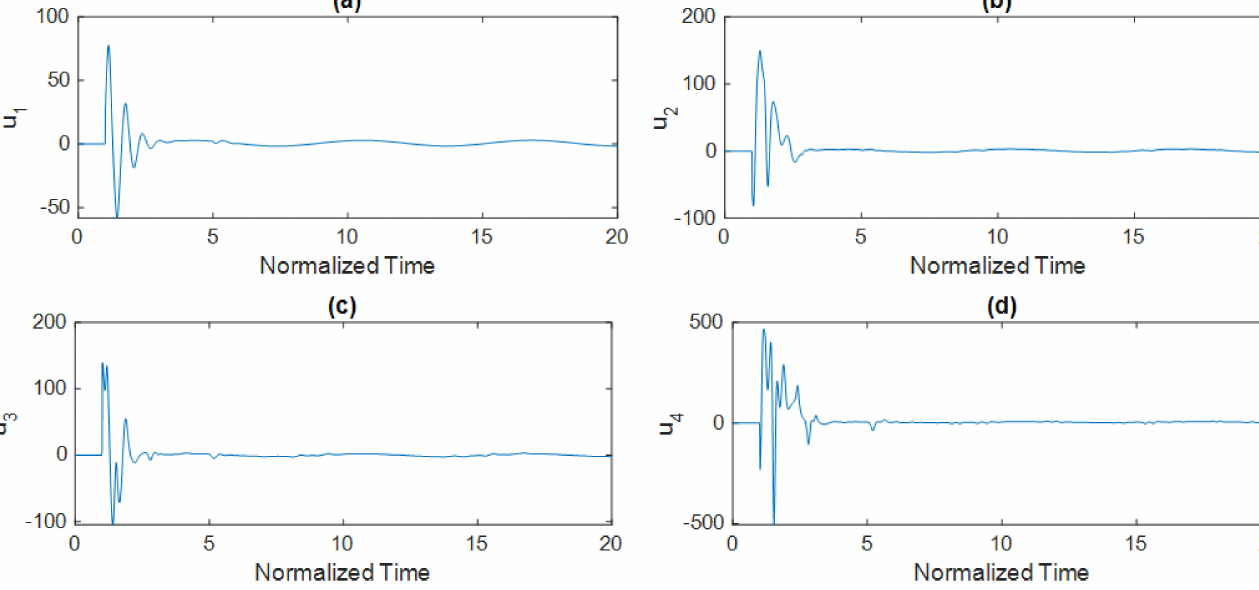
Figure 6. The control input based on the offered control methodology where there are bias faults. Time history of ( a ) u_1, ( b ) u_2, ( c ) u_3, ( d )